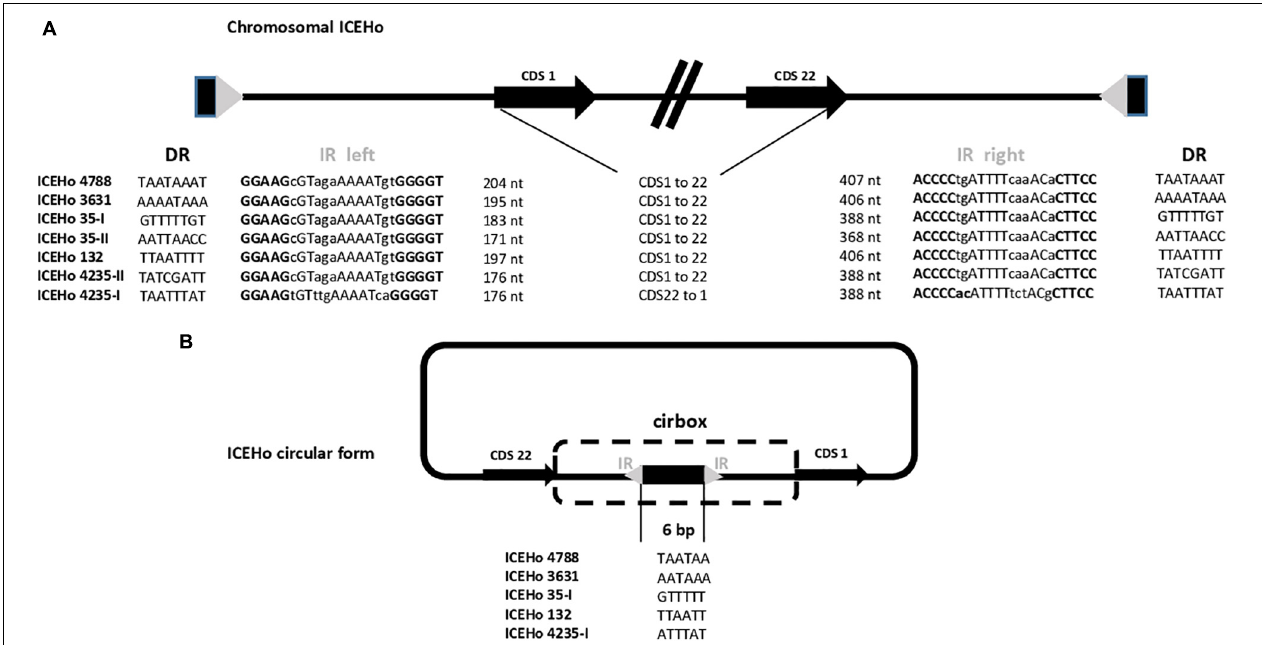
FIGURE 2 | Chromosomal and extrachromosomal circular forms of ICEHo. (A) Schematic representation of the chromosomal loci containing ICEHos in the five sequenced M. hominis strains harboring ICEHos able to circularize. The chromosomal ICEs possess two imperfect inverted repeats (IRs, represented by a gray triangle) at each end that are flanked by two 8-bp direct repeats (DRs, represented by a black rectangle). (B) Extrachromosomal ICEHo circular forms with details of the 6-bp coupling sequences. Excision and circularization from the M. hominis donor chromosome resulted in a free circular form, in which the junction contains a 6-bp coupling region. This coupling region corresponds to a juxtaposition of the DRs flanking the